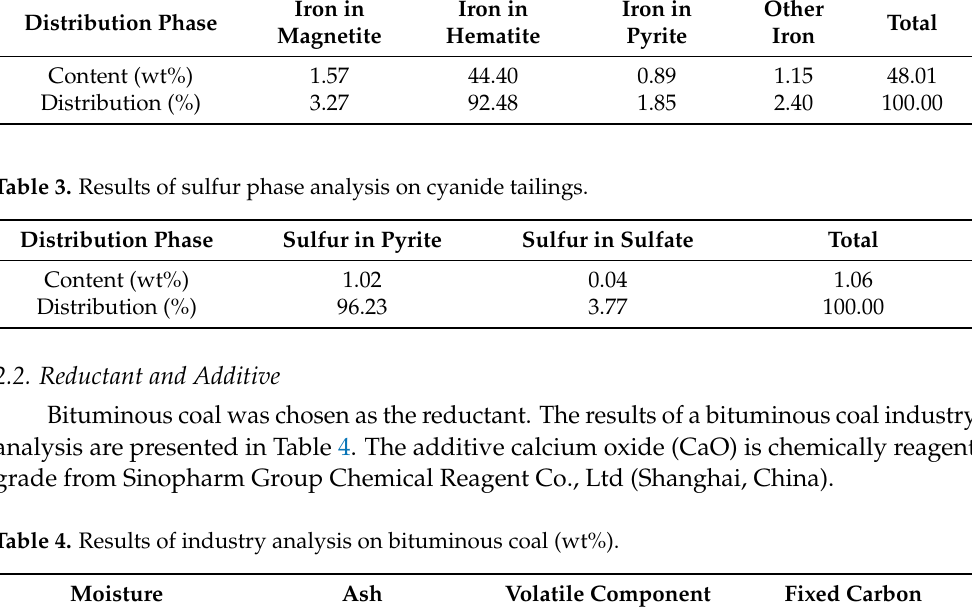
Figure 1. Results of XRD analysis of cyanide tailings. Table 2. Results of iron phase analysis on cyanide tailings.